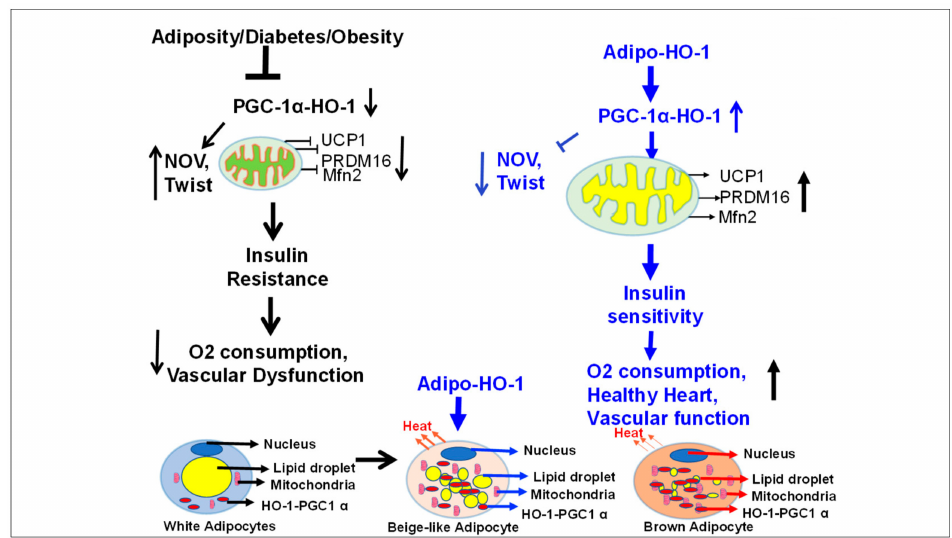
Figure 12. Schematic presentation of postulated mechanisms by which adipocyte-specific HO-1 expression promotes the reprogramming of adipose tissue obese phenotype to a healthy brown-fat phenotype. Obesityleadstoa markedsuppression ofHO-1withinadipocytes, resultingwithsubsequent increases of inflammatory adipokines, including NOV and TWIST, and leading to suppression of thermogenic genes and mitochondrial dysfunction. These changes at the level of adipocytes are accompanied with reduced energy consumption, impaired vascular function, and insulin resistance. A targeted overexpression of HO-1 within adipocytes prevents and reverses these changes by stimulating PGC1- α expression, leading to an increase in thermogenic genes (UCP1 and PRDM16) and a decrease in inflammatory adipokines, (NOV and TWIST). This, in turn, increases mitochondrial respiration, oxygen consumption, and insulin receptor phosphorylation, all of which contribute to improving vascular function and increasing expression of heart protective genes. Hence, selective expression of adipocyte HO-1 o ff ers a multifactorial clinical approach to the treatment of obesity concomitant metabolic